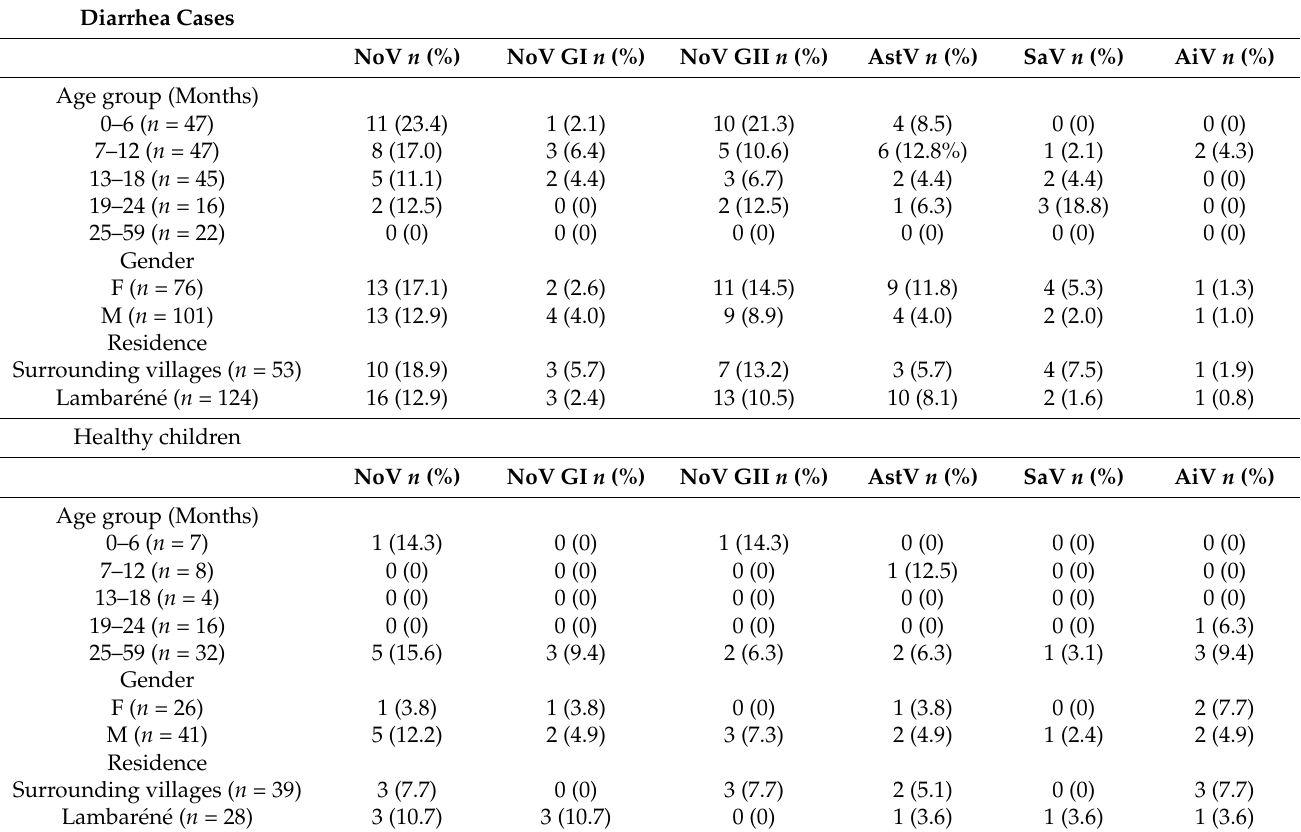
Table 2. Distribution of enteric viruses in the study population according age, gender, and